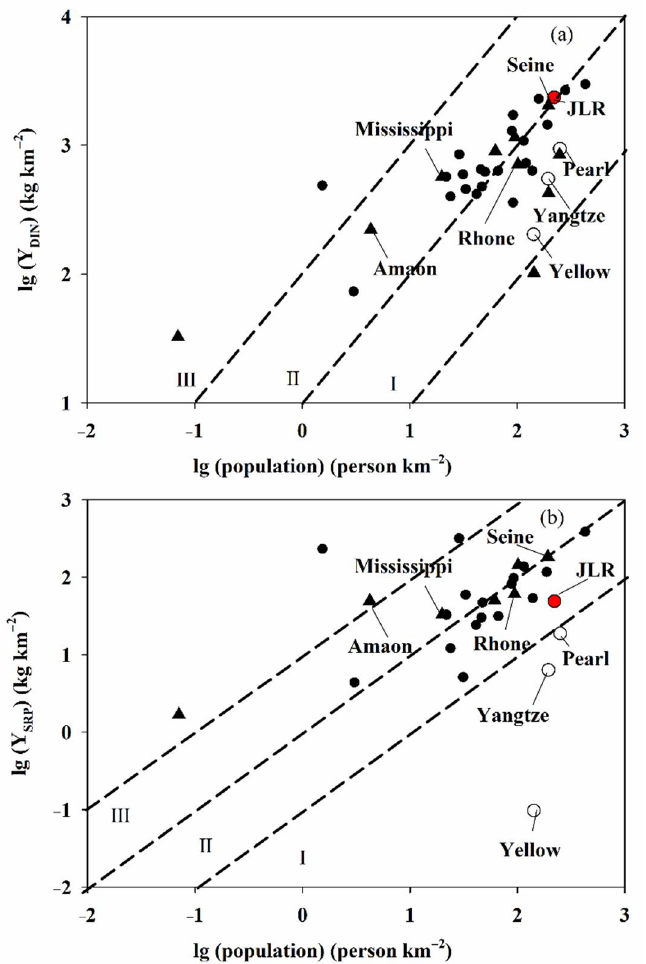
Figure 8. The relationship between the areal yields of ( a ) DIN and ( b ) SRP and population densities in worldwide rivers. The black dots, black triangles, and red dots represent the average areal yields of DIN and SRP in large Chinese rivers [25,68] , worldwide river basins [64] , and the JLR (this study), respectively. The black circles denote the areal yields of TN and TP in three large Chinese rivers [41]. Line I, line II and line III in ( a ) denote 1 kg N person −1 , 10 kg N person −1 and 100 kg N person −1 , respectively, while in ( b ) they denote 0.1 kg P person −1 , 1 kg P person −1 and 10 kg P person −1 , respectively.